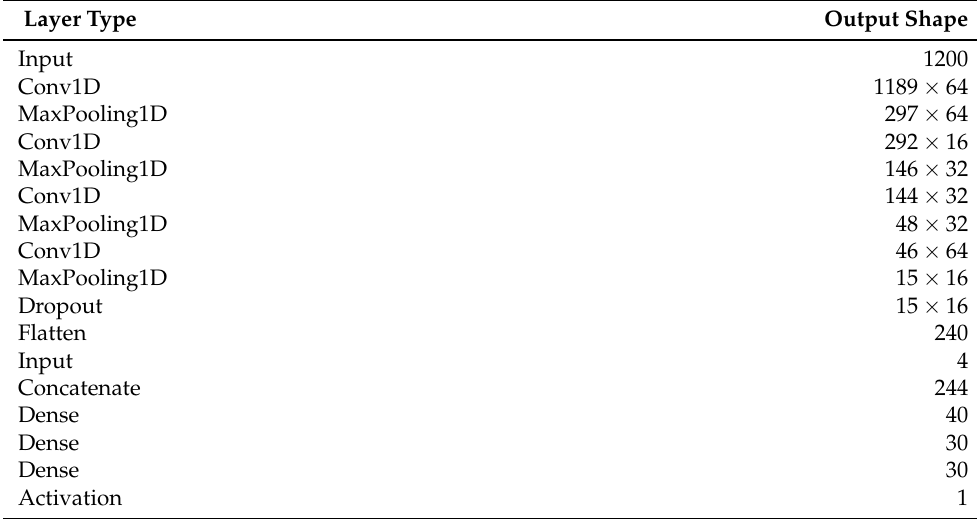
Table 2. Description of layers used in the model to identify initiation and termination positions of impulsive part of the signals. For each layer the dimension of the layer output is